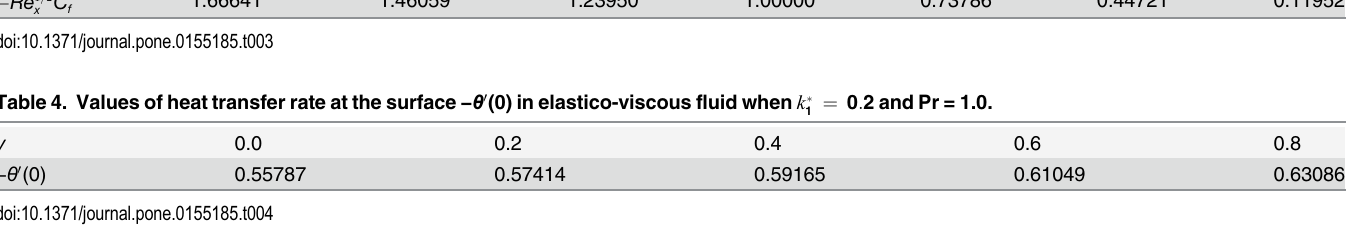
elastico-viscous fl uid ð k (cid:3)